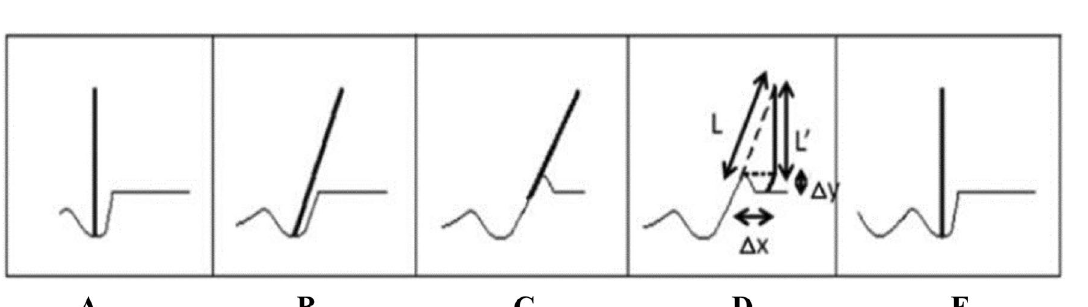
Fig. 5 Mechanism of tool sticking and jumping out of workpiece for creating channel with electrochemical discharge process: a Expansion and penetration of tool into workpiece, b Sticking of